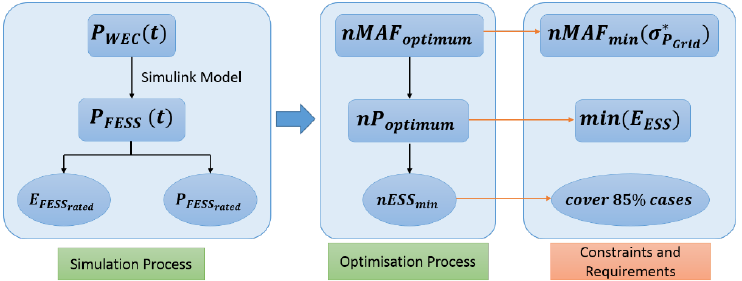
Figure 9. Flowchart of the ESS dimensioning and control parameter selection methodology.